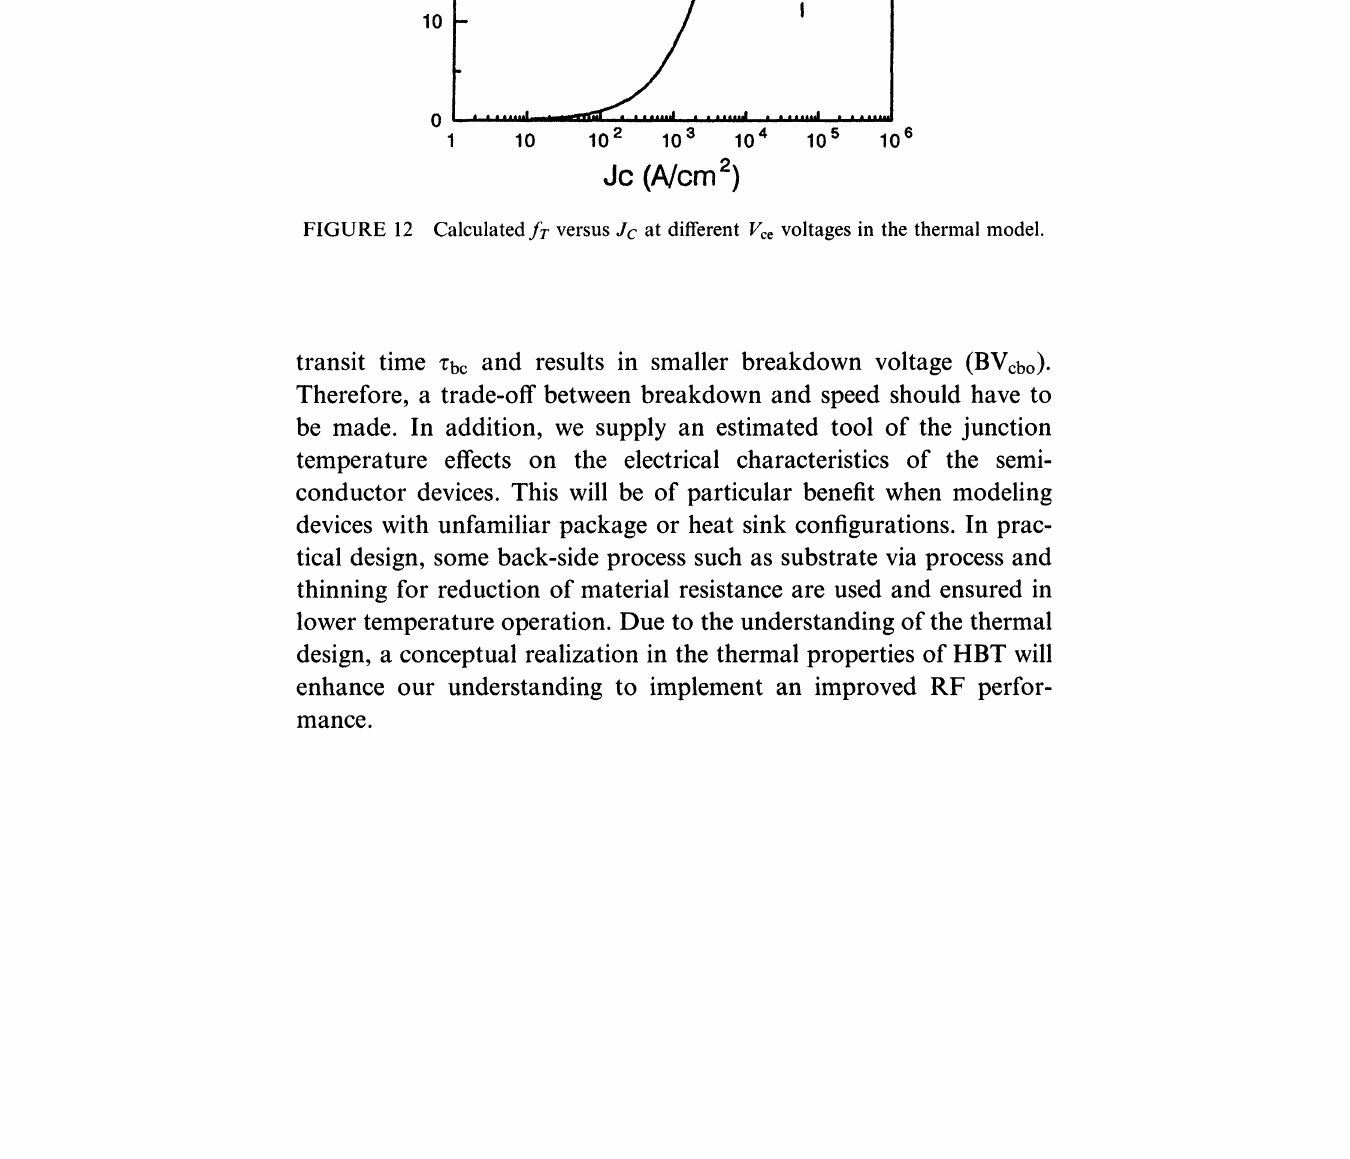
FIGURE 12 Calculated fr versus Jc at different Vce voltages in the thermal model.